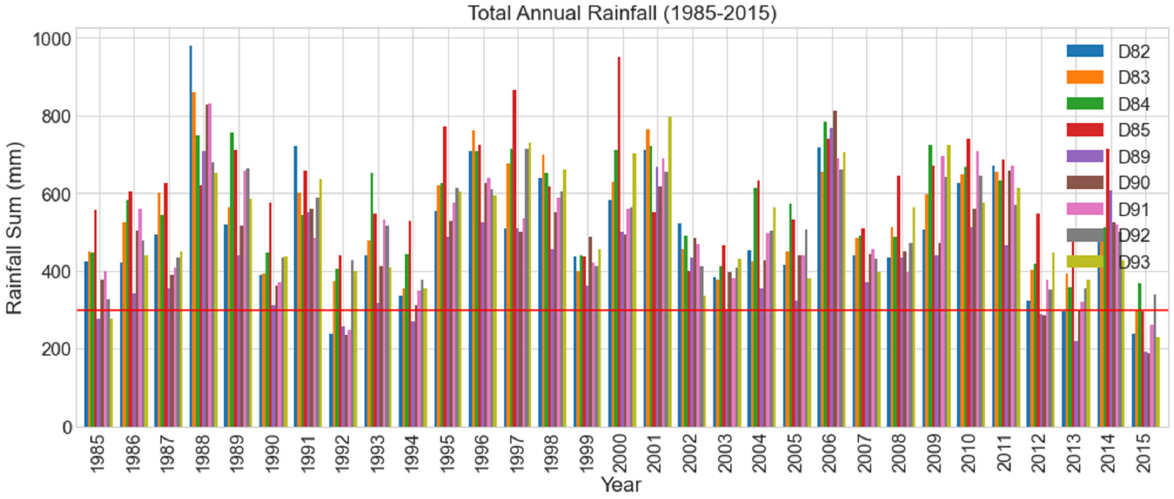
Figure 3. Total Annual Rainfall for rainfall districts (82,83,84,85,89,90,91,92,93) from 1985 to